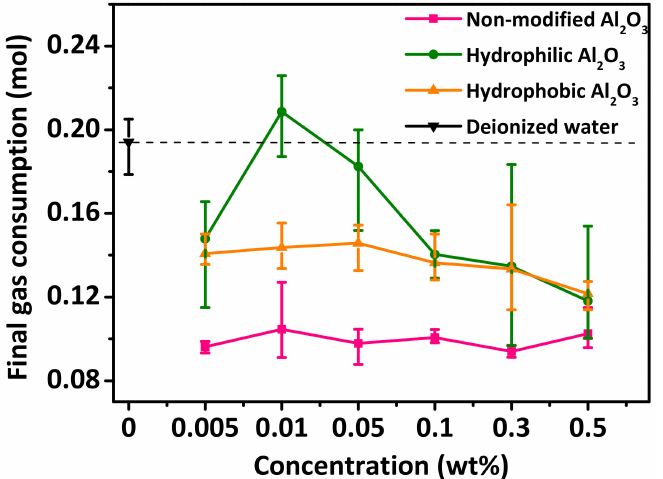
Figure 8. E ff ects of the di ff erent concentrations and types of Al 2 O 3 nanoparticles on the kinetics of CO 2 hydrate formation. The final gas consumption versus the dispersed solution